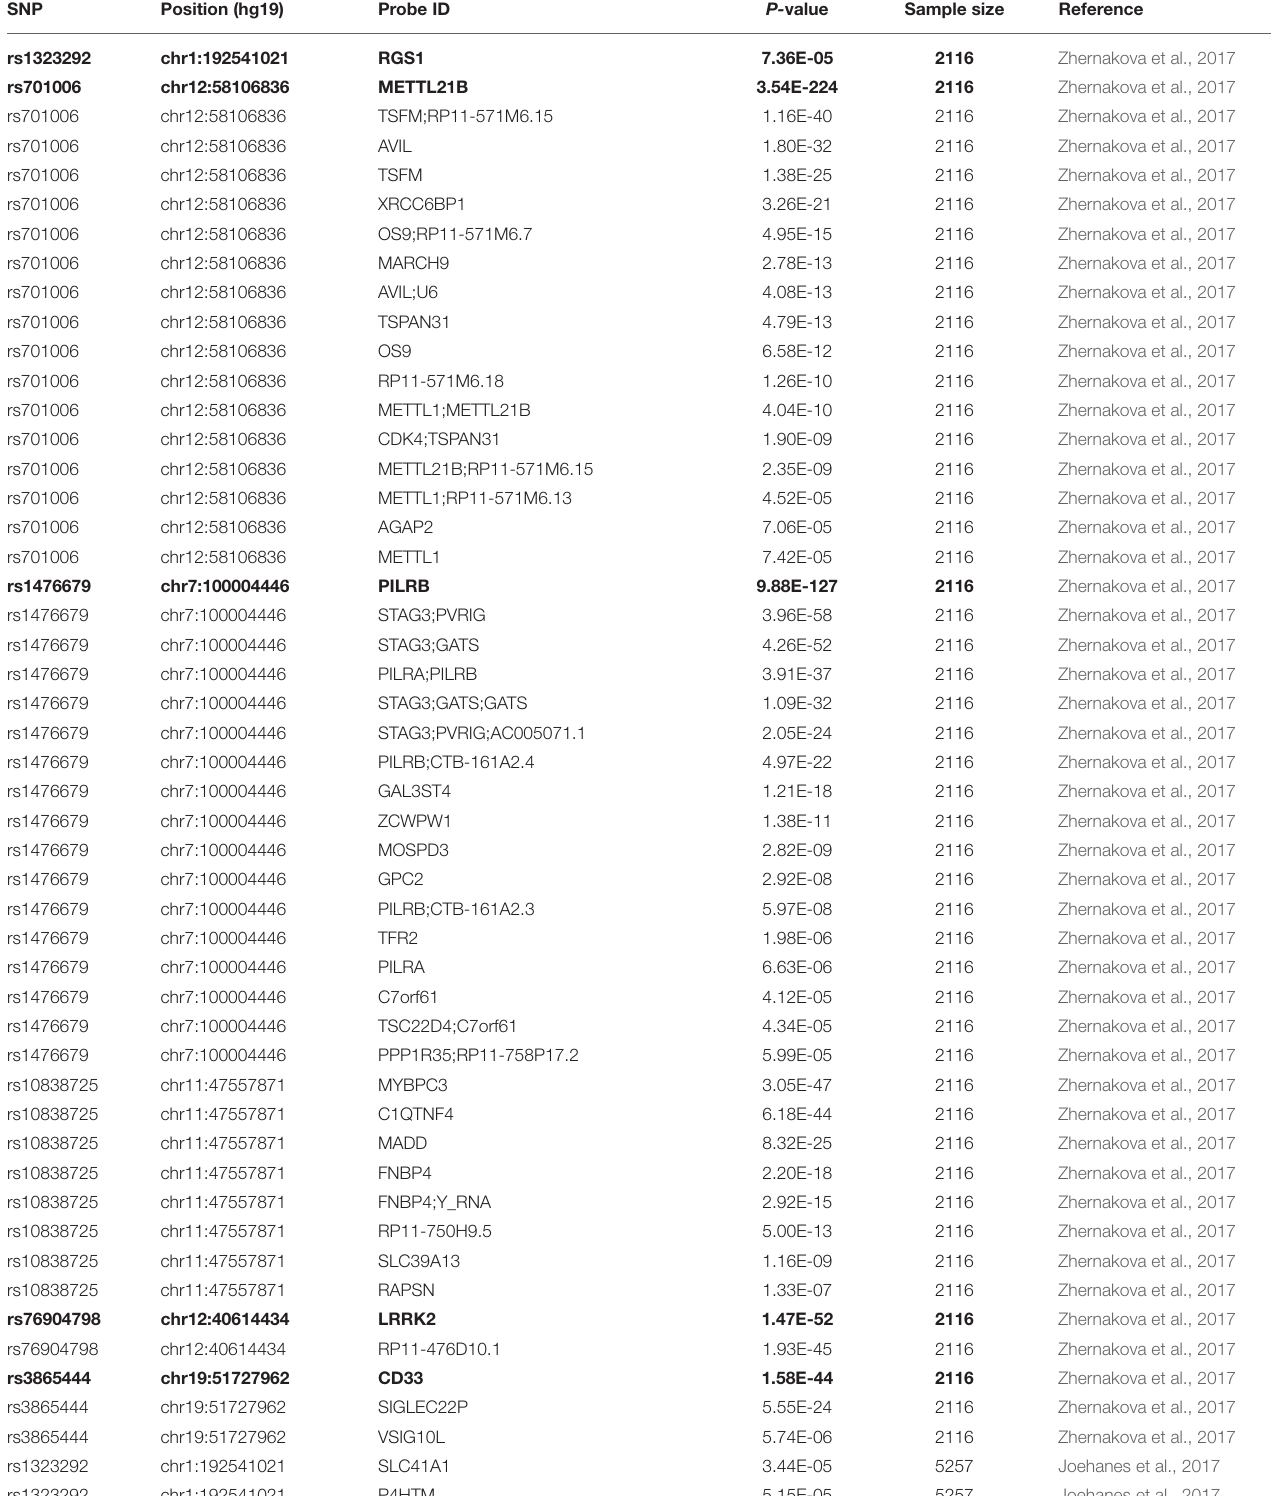
TABLE 4 | eQTL analysis of six neurodegenerative disease variants in whole